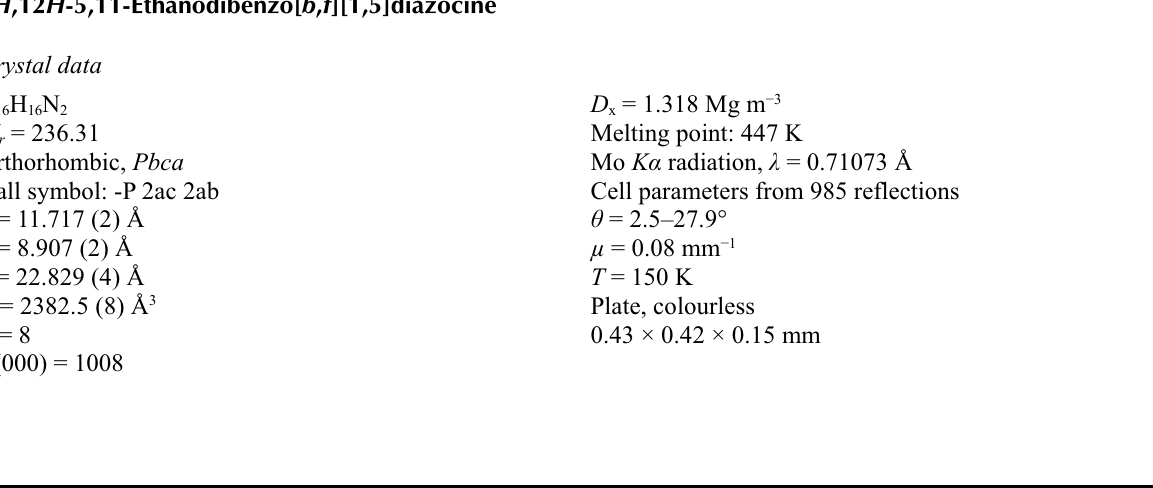
Synthetic scheme for the synthesis of (I) showing the numbering system used in naming the compound. 6 H ,12 H -5,11-Ethanodibenzo[ b , f